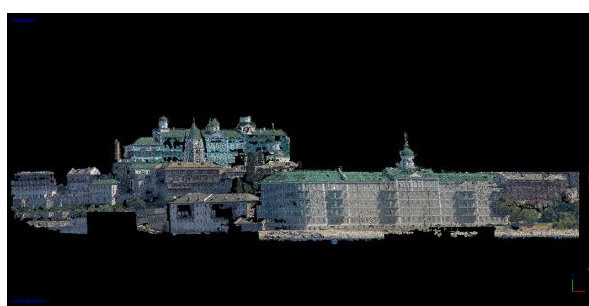
Figure 8 . The Monastery of St. Pantaleimon. Cloud of